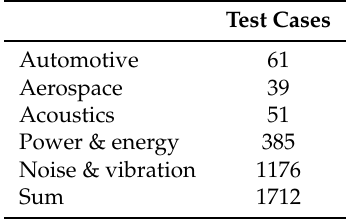
Table 1. Domains and number of in-house automated